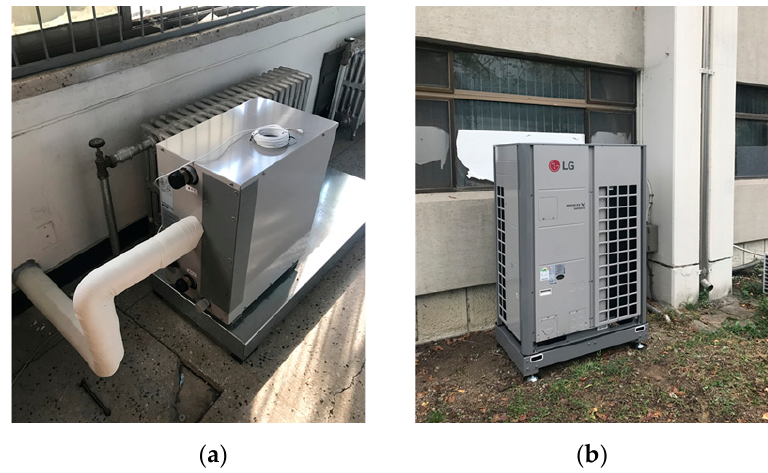
Figure 1. Heat pump System. ( a ) Indoor unit, ( b ) Outdoor unit. Table 2. System specification.